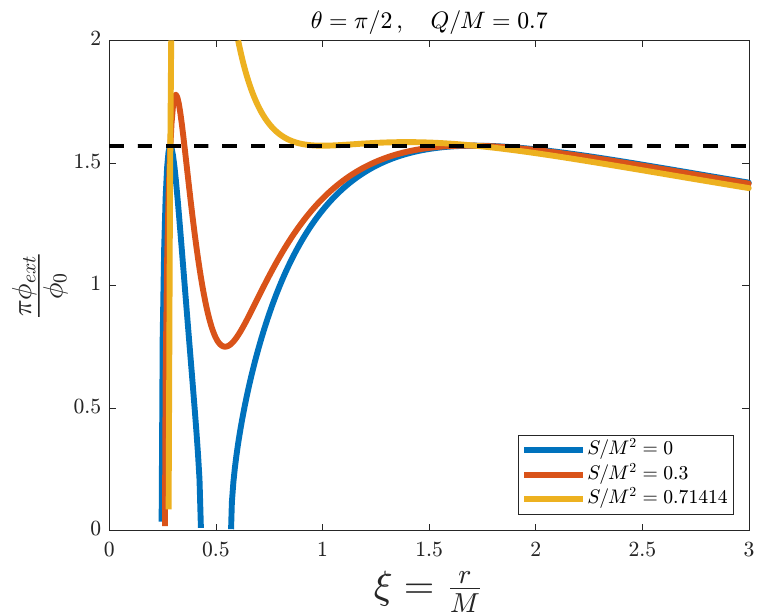
Figure 12. External magnetic flux πφ ext / φ 0 versus the adimensional distance ξ = r / M for the simulation of a Kerr–Newman black hole with fixed θ = π /2 and A = Q / M = 0.7, and for different values of B = S / M 2 . The dashed line represents the threshold value πφ ext / φ 0 = π /2.